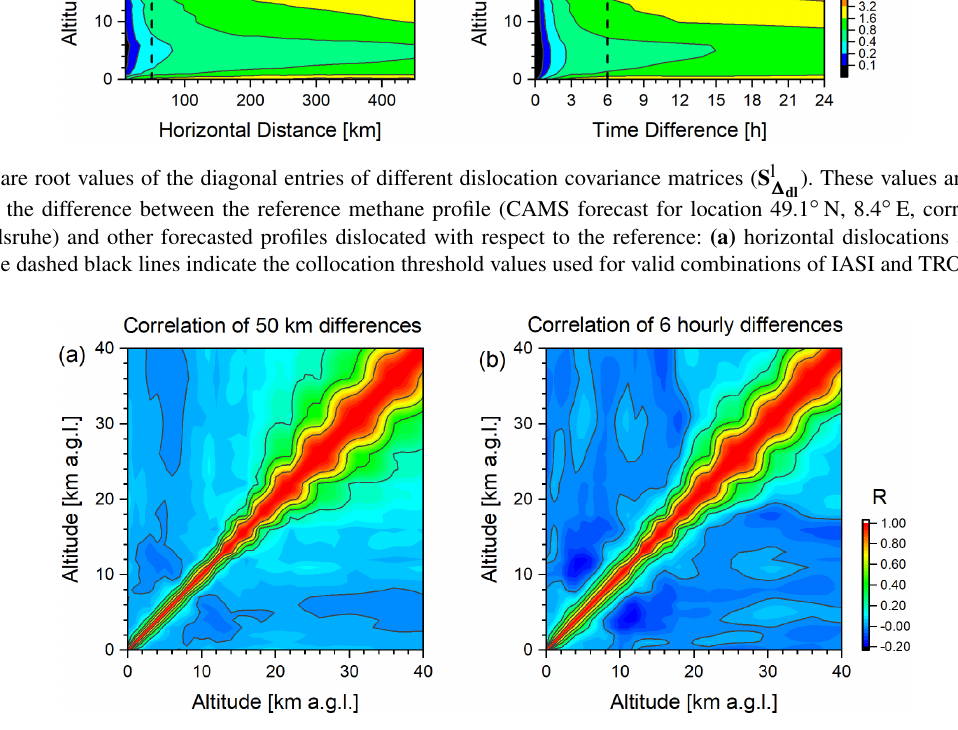
. Shown are the vertical correlation matrices for the (cid:49) dl